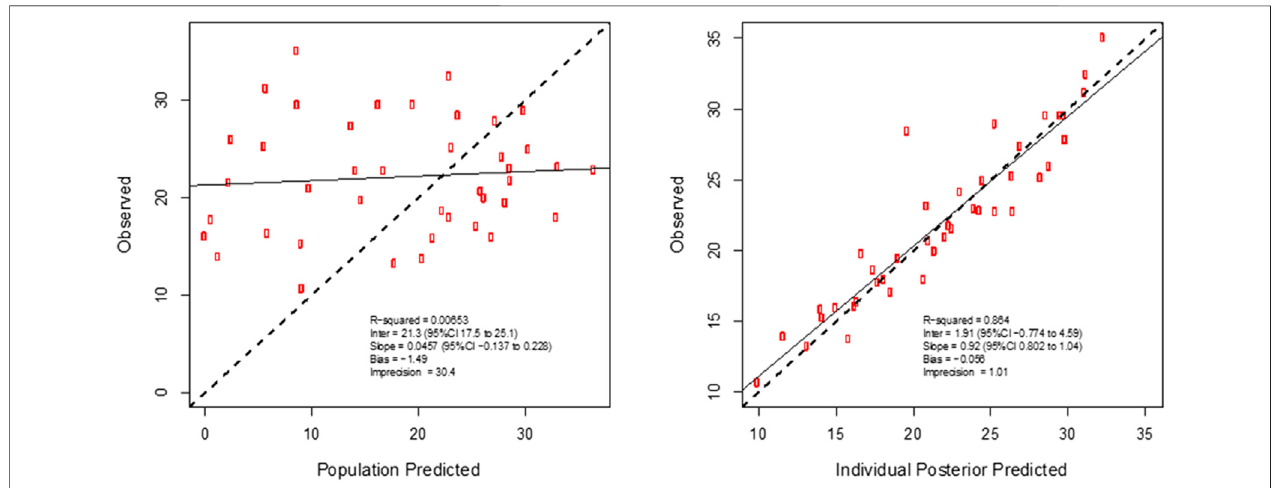
FIGURE 3 | Individual predicted concentration diagnostic plots for the fi nal covariate model for plasma vancomycin concentrations. Data are presented in mg/L.